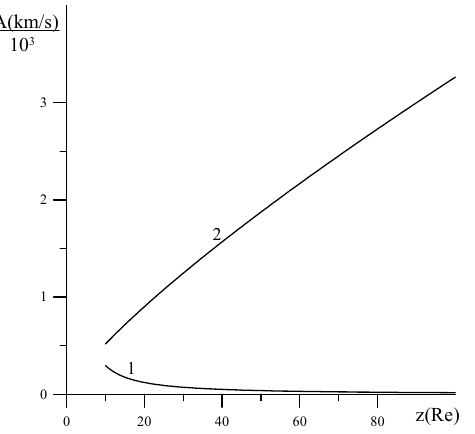
Fig. 3. Average statistical distribution of the Alfv´en velocity in the plasma sheet (1) and in the magnetotail lobes (2) in the tailward direction. The distributions are plotted using the approximation formulas in Sergeev and Tsyganenko (1980) for satellite-registered plasma concentration and geomagnetic field intensity. The origin z =0 is chosen at the Earth’s